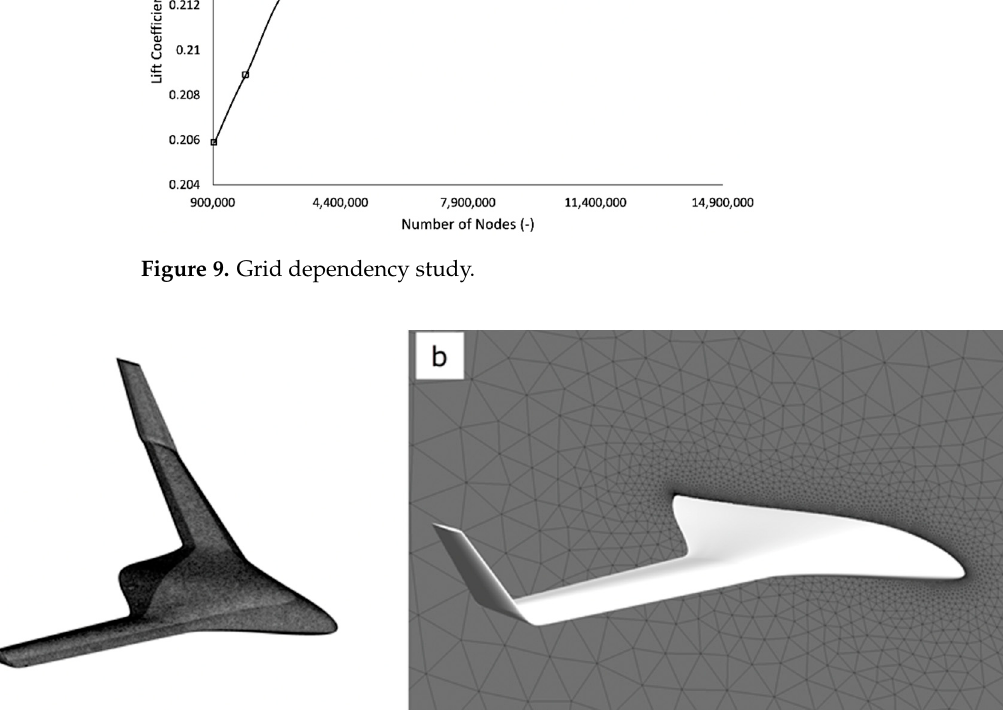
Figure 10. Computational mesh on the surface ( a ) and around ( b ) the BWB UAV reference configuration [8]. Table 2. Computational Fluid Dynamics (CFD) cases modelled for the present